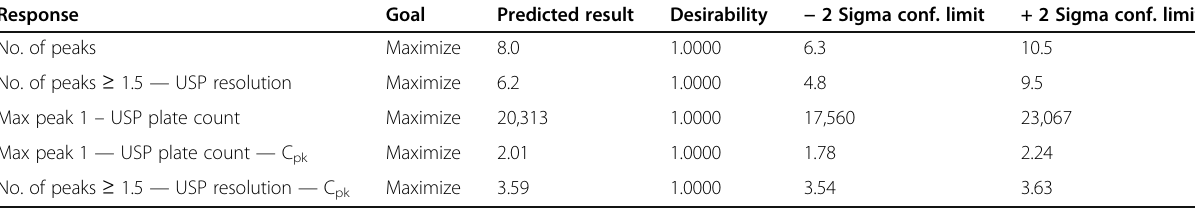
Table 4 Predicted results and confidence intervals for the selected responses of the optimized method